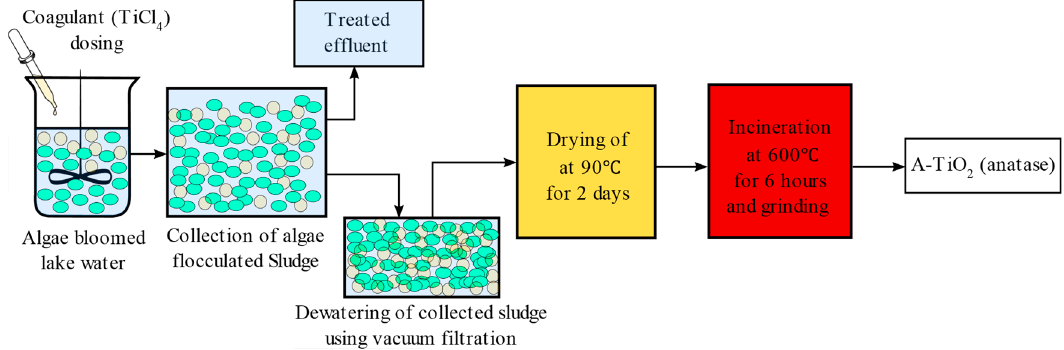
Figure 8. Preparation of A-TiO 2 using Ti flocculated algal sludge.